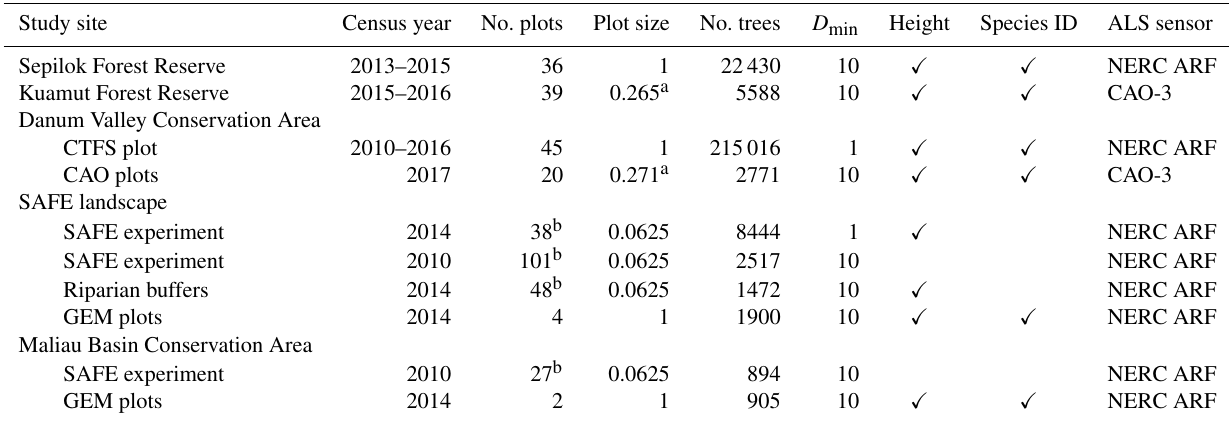
Table 1. Summary of permanent forest plot data collected at each study site and description of which ALS sensor was used at each location. Plot size is in hectares, while minimum stem diameter thresholds ( D min ) are given in